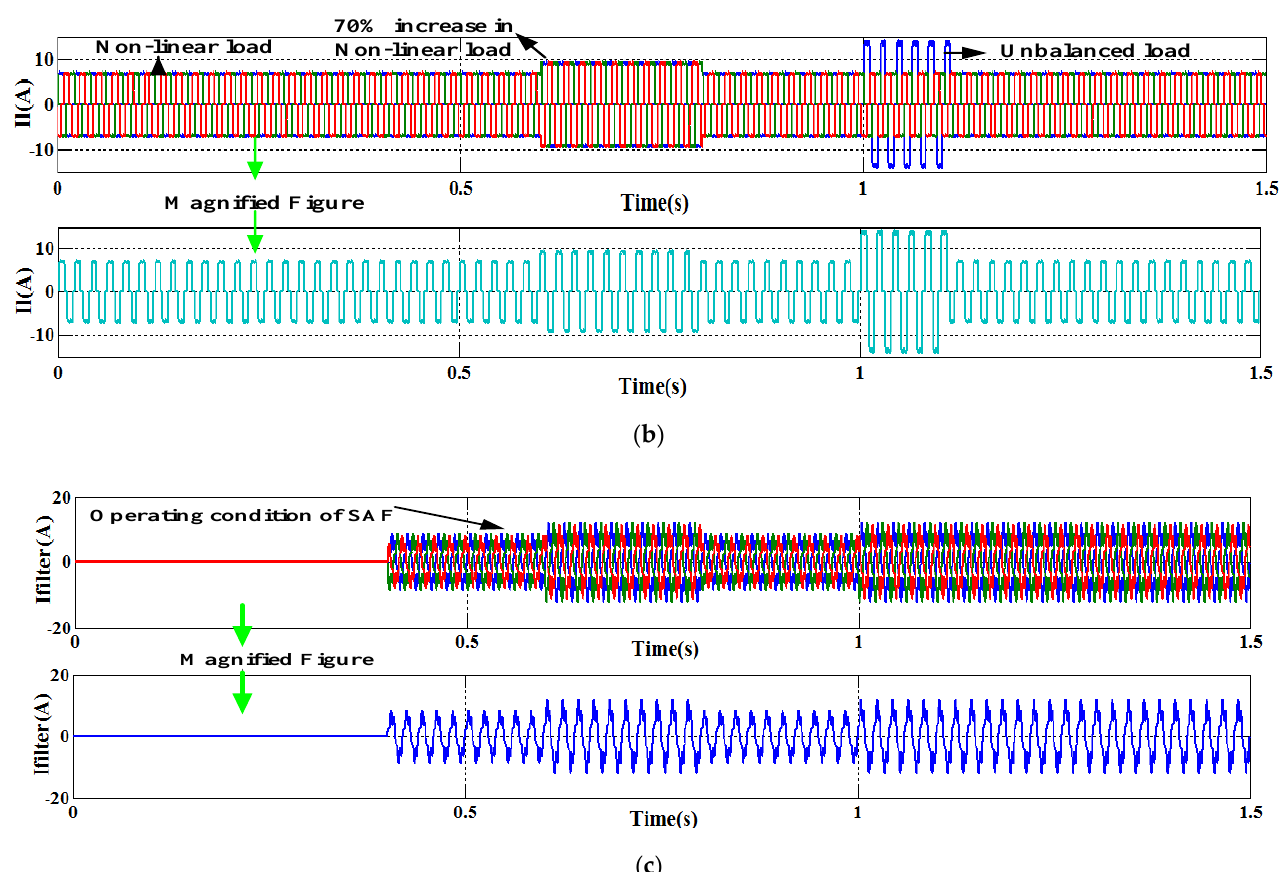
Figure 8. ( a ) Grid voltage results, ( b ) non-linear load current results, and ( c ) 3 𝜑 4W VSI output current results.